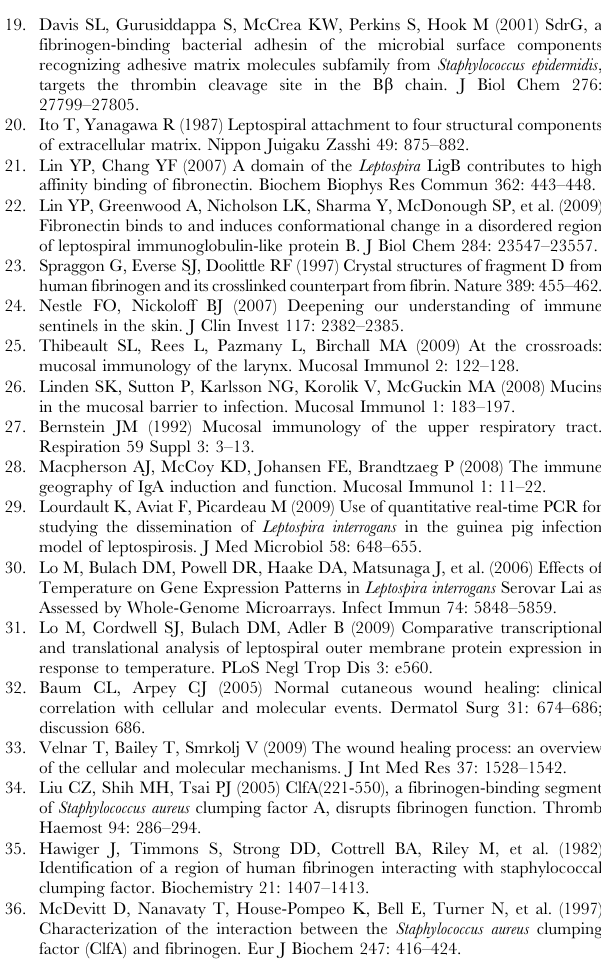
Figure S1 Lig expression in L. biflexa transformed with lig genes from L. interrogans . LigA and LigB expression was